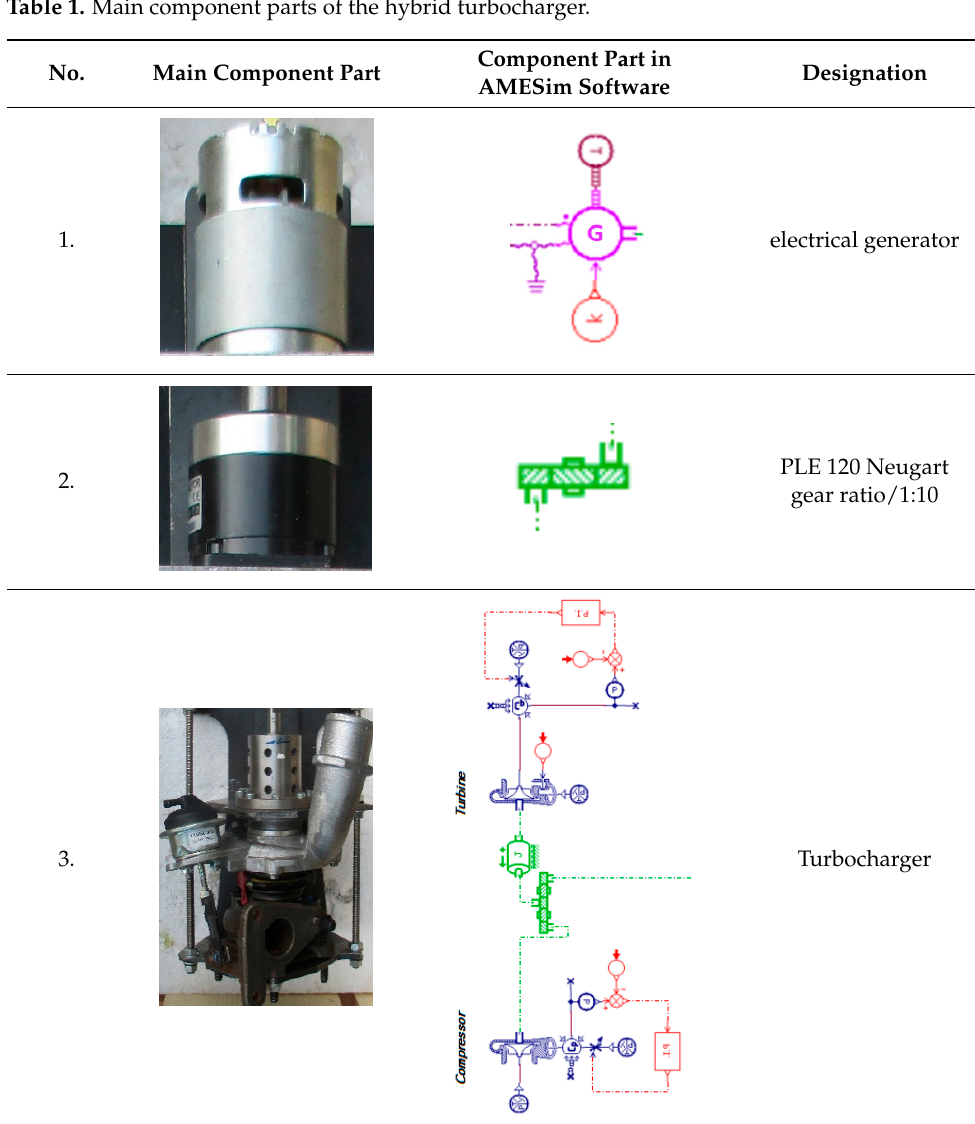
Figure 2. The structure of the hybrid turbocharger design [42]. Table 1. Main component parts of the hybrid turbocharger.